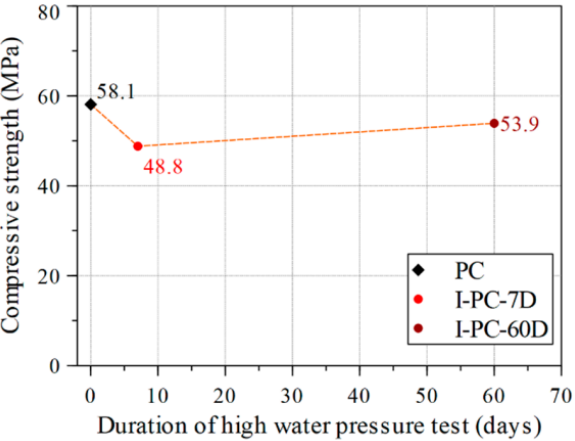
Figure 8. Compressive strength versus duration under sustained high water